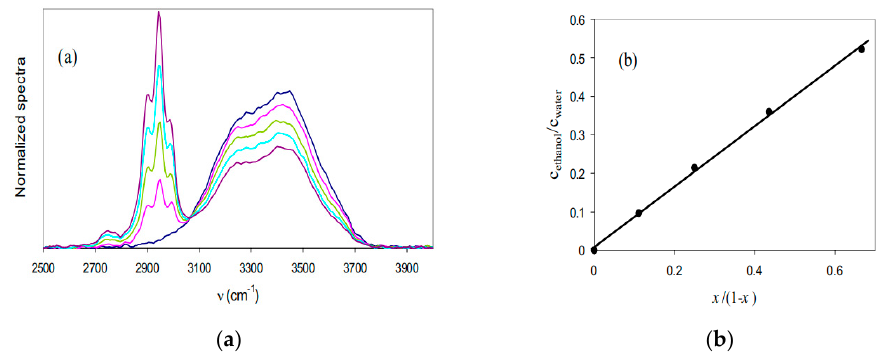
Figure 17. ( a ) Using LOF to measure the Raman spectra of ethanol at 0, 0.1, 0.2, 0.3, and 0.4 concen- trations. The peaks at 2905, 2949, and 2994 cm − 1 correspond to ethanol. ( b ) Ethanol/water ratio as a function of the true volume fraction of ethanol x. Errors on the score ratios are less than 1%. Repro- duced with permission [82].